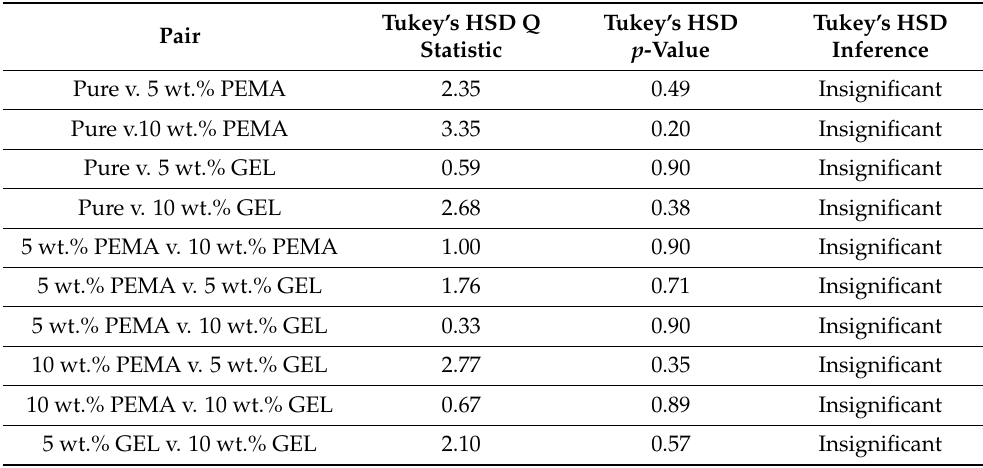
Table 3. Tukey’s statistical analysis for the measurement pairs, for the Pure, 5 wt.% PEMA, 10 wt.% PEMA and 5 wt.% GEL and 10 wt.% GEL PL, adhesion strengths, respectively. Tukey’s HSD Pair